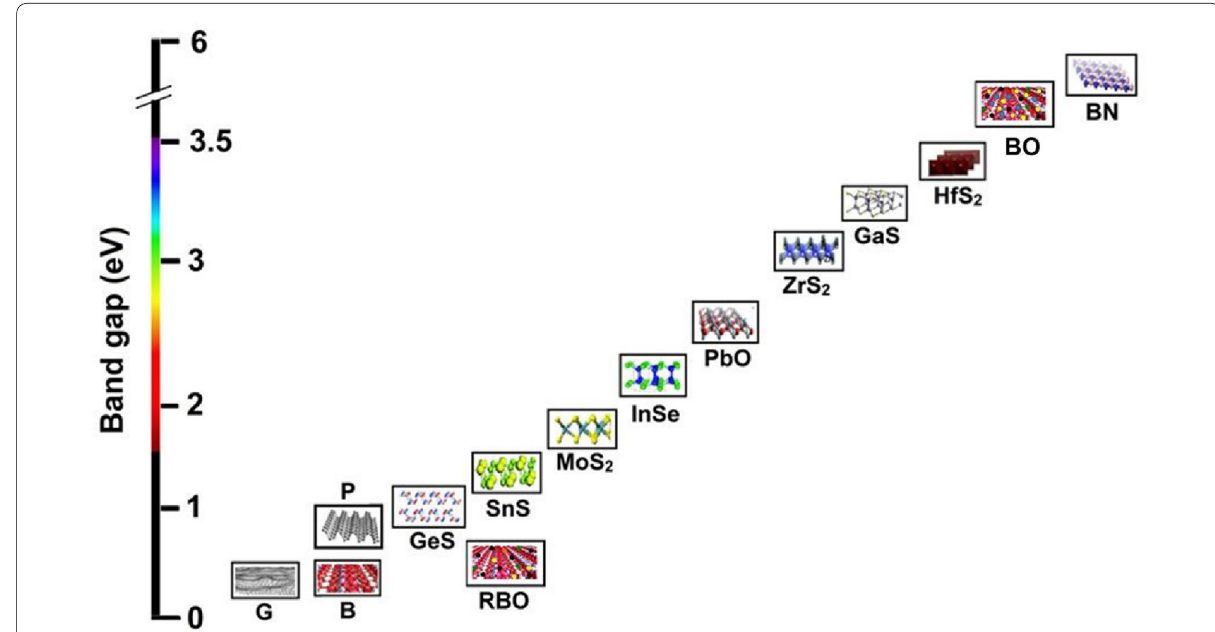
Fig. 3 Band gaps chart for the family of 2D materials